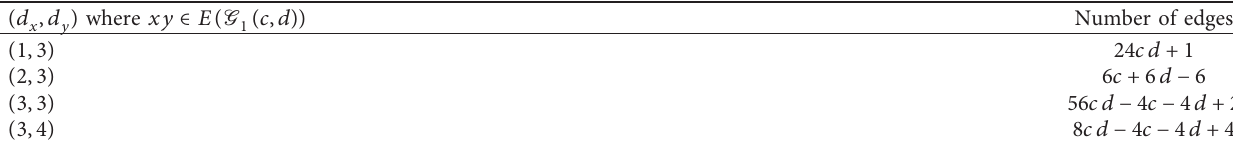
( c, d ) based on degrees of end vertices of each edge. 1